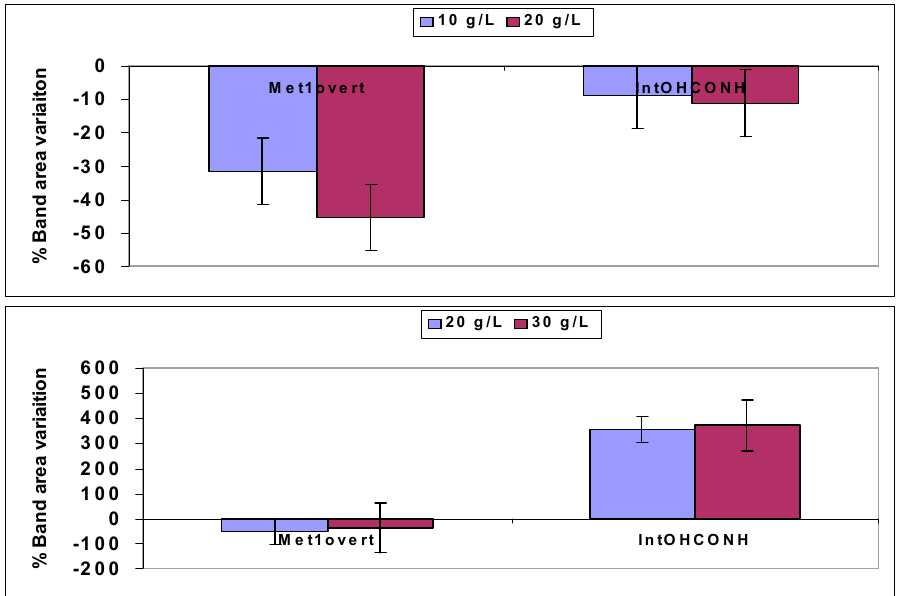
Figure 9. Bar charts of the band area variation with respect to the control sample observed in the FTNIR spectra for the As exposure of the June (upper) and July (bottom) plots. Here, the results are the average of the three replicated spectra for each As exposure.